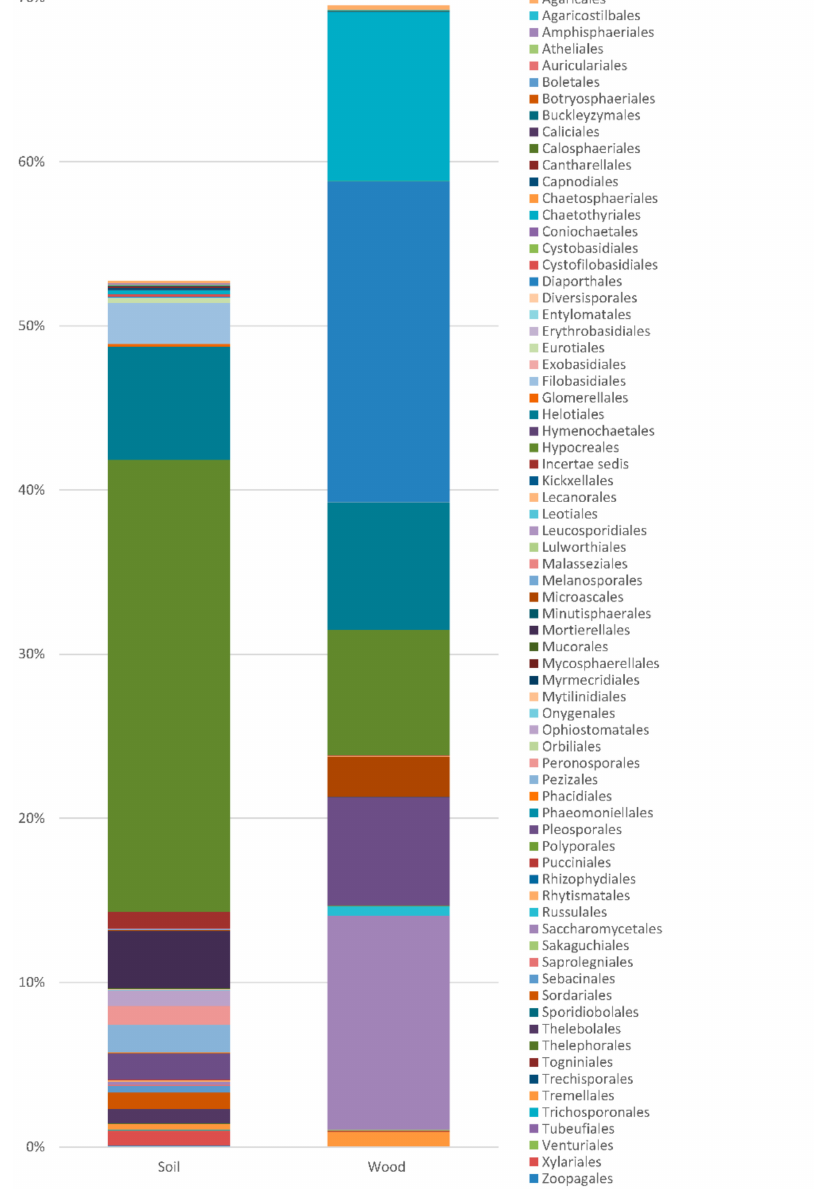
Figure 3. Frequency of the fungi in taxonomic